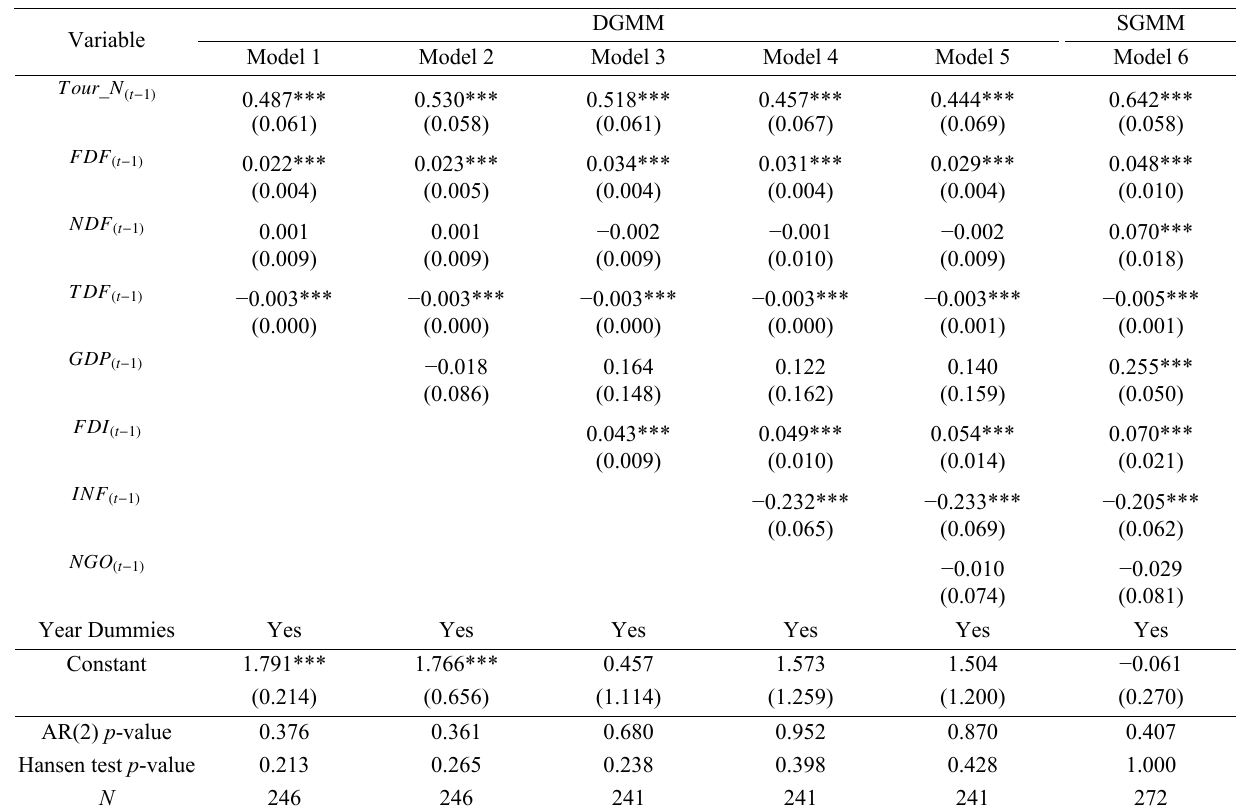
Table 2 Dynamic panel regressions of predicting the effect of literary destination familiarity on inbound tourism (1994–2004).